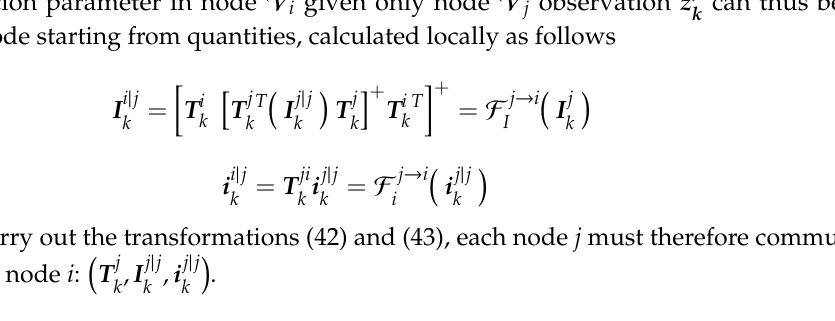
Figure 1. Information Space Intermodal Transformation map.